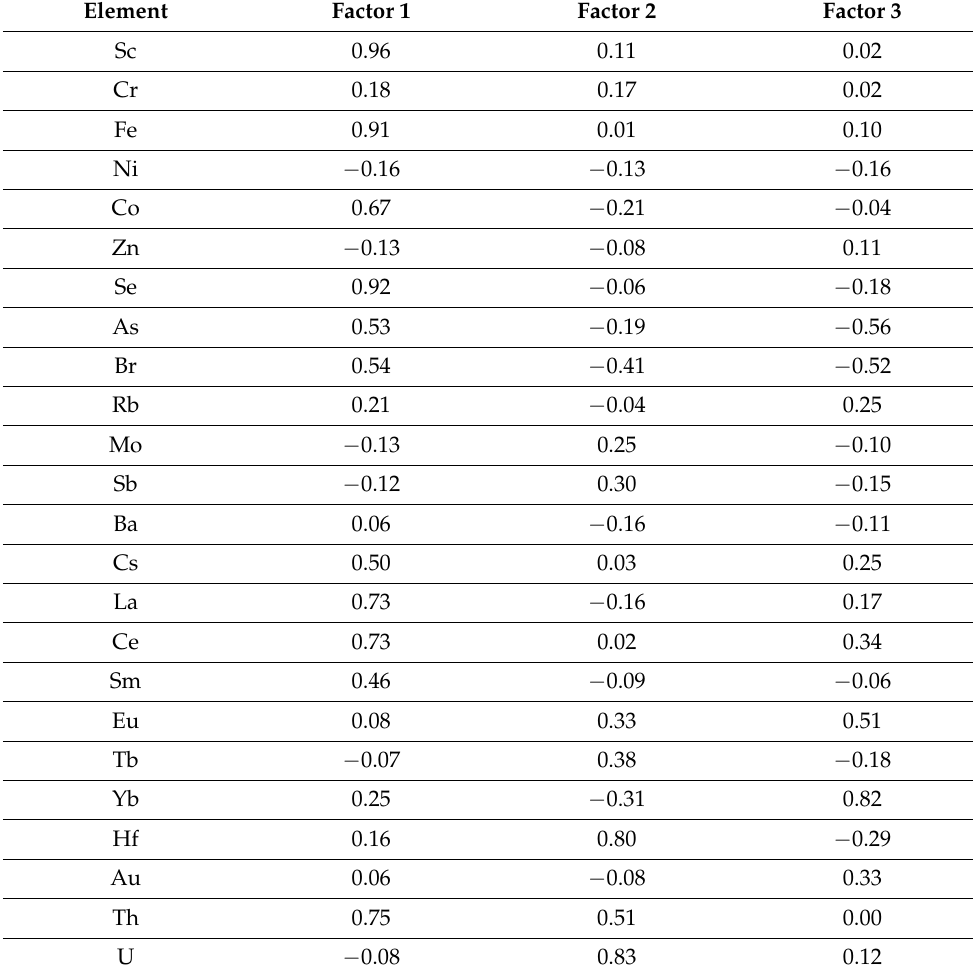
Table 3. The factor loadings based on the correlation matrix.